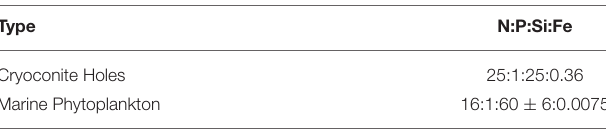
TABLE 2 | N:P:Si:Fe ratios of Canada Glacier cryoconite holes vs. marine phytoplankton.